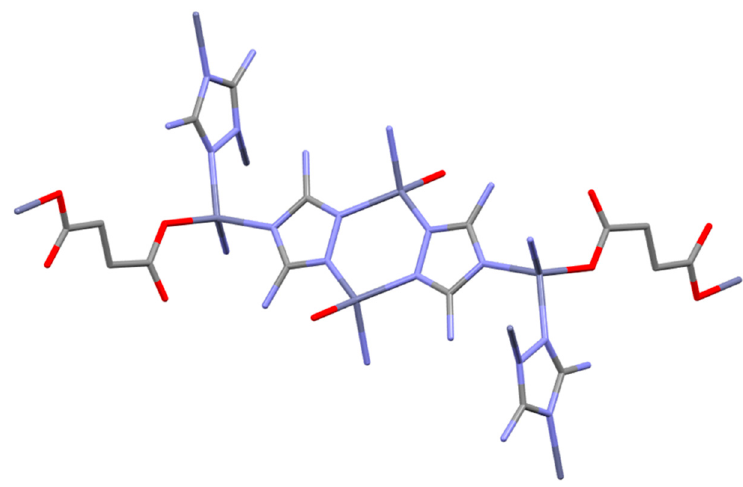
Figure 4. Two-dimensional polymer from units of [Zn 2 (datrz) 2 ] [93]. (Zn, N, O). Another representative of MOFs is [Zn(tpb)(fu)] ¨ 2H 2 O, whose 1D polymers (Figure 5) are bridged by a monodentate fumaric acid anion to form a 3D network (Figure 5) [67]. The tpb ligand is tetradentate and coordinates to four different zinc cations. The complex shows an intense fluorescence band (422 nm); it is not MLCT and LMCT charge transfer, but it is likely to be π – π * fluorescence emission. This type of emission is explained as enhanced emission of the tpb ligand when the ligand (tpb) is coordinated to zinc, and this circumstance strengthens the conformational rigidity of the tpb ligand. Similar emissions and the situations that cause these emissions are described for other coordination compounds such as [Zn(H 2 O) 2 (dbipy)(fu)] and [Zn(fu)(bpmp)(H 2 O) 2 ] [49,51]. For the coordination polymer {[Zn(bib)(fu)] ¨ CH 3 OH} n , a diamond-type network is formed (Figure 6), which is composed of two monodentate-coordinated fu 2 ´ and two 1,4- bis(2-methyl-imidazol-1-yl)butane (bib) ligands, for which the coordination mode is syn- anti . The bridge ligand bib, which coordinates to zinc cations {Zn-bib-Zn-bib-Zn} n , forms a 1D chain ( meso-helix ). Similarly, a 1D polymer {Zn-fu-Zn-fu-Zn} n is formed, which is meso-helical , where the bridge is a fumaric acid anion. The two 1D polymers are con- structed along different axes, which are connected to each other to form a 3D diamond-like rhombic structure. The 3D network contains potential voids. The equivalent diamond net- works, which are independent, interpenetrate each other (as a quadruple interpenetrating topology)